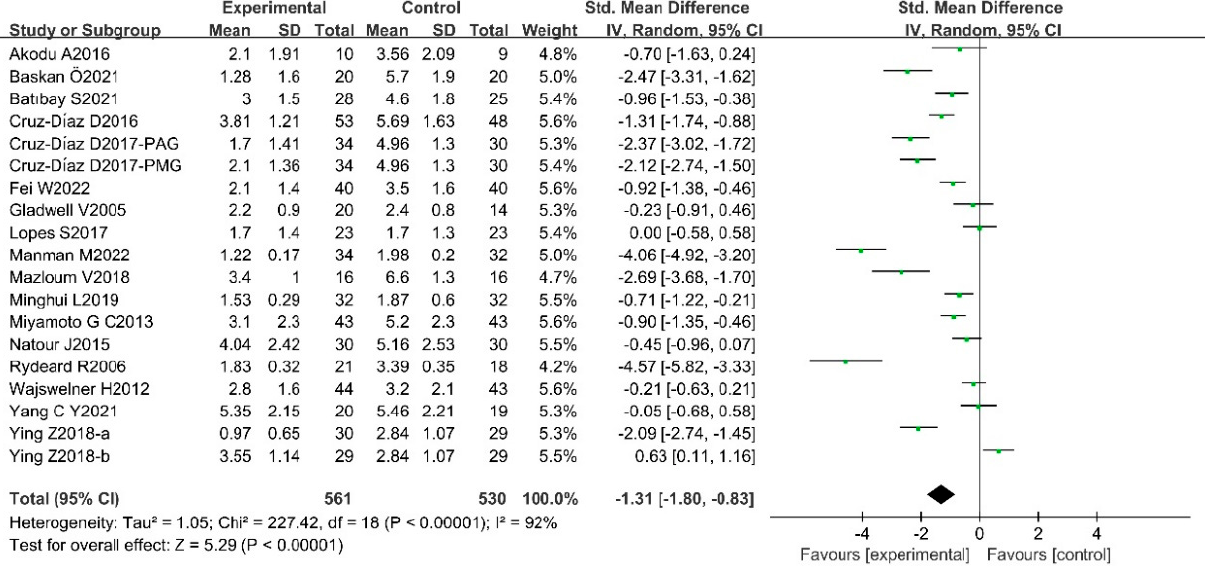
Figure 4. Figure 4. Meta-analysis of the effect of Pilates on Pain Scale in CLBP patients [12,18–23,36,43,45,48– 52,54,55].